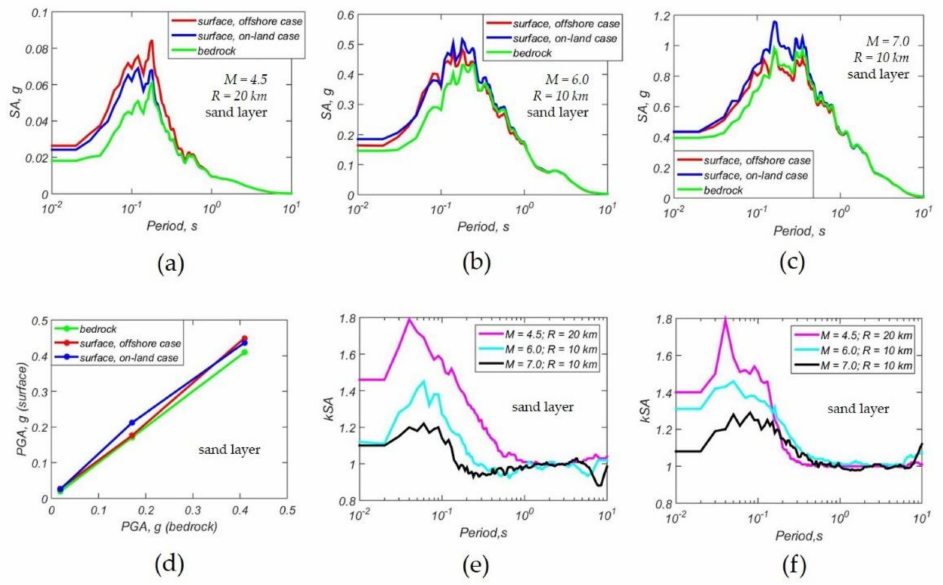
Figure 13. Modeling results for the case of sand layer: ( a – c ) response spectral acceleration SA ( T , 5% ); ( d ) PGA values; ( e ) acceleration amplification curves for offshore case; ( f ) acceleration amplification curves for the onshore